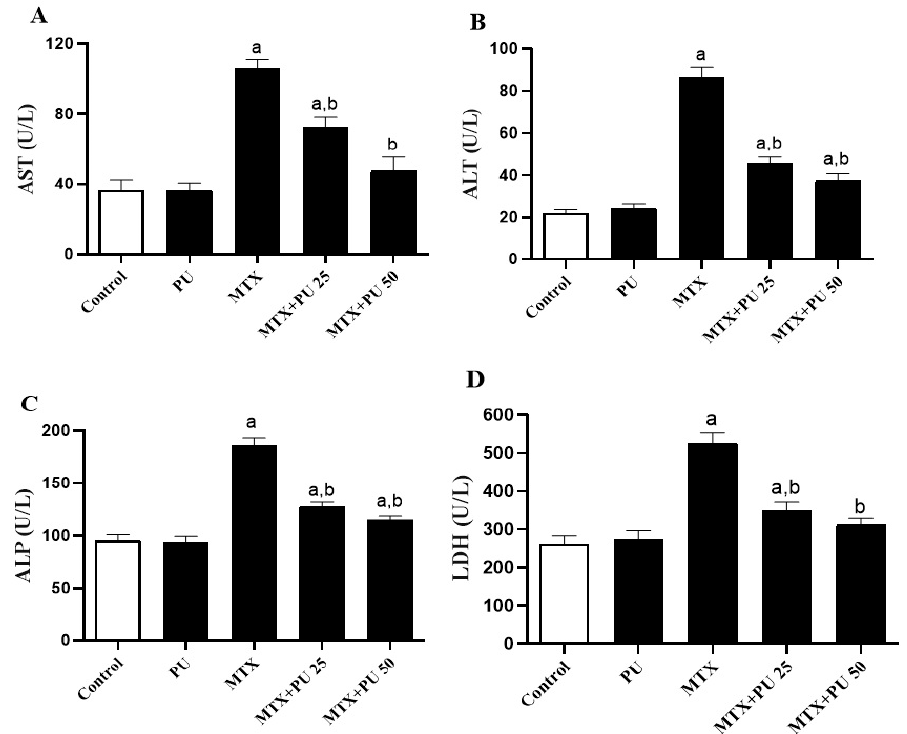
Figure 1. PU ameliorates liver function in mice exposed to MTX. PU reduced the blood levels of ( A ) AST, ( B ) ALT, ( C ) ALP, and ( D ) LDH activities in MTX-injected mice. Results are expressed as mean ± SEM, ( n = 6). a indicates significant ( p < 0.05) vs. control, while b indicates significant ( p < 0.05) vs. MTX.